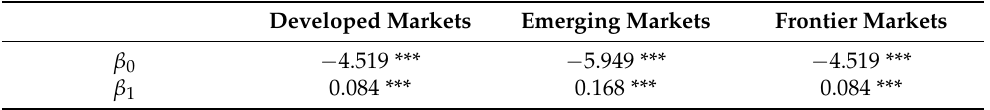
Table 4. Variables in equation.